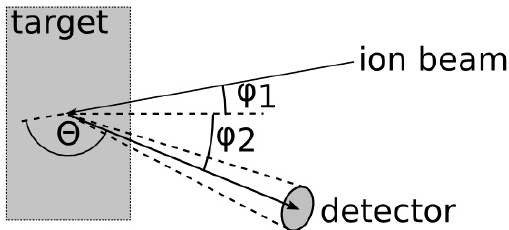
Figure 1. Schematic representation of Rutherford backscattering spectrometry (RBS). The angles of incidence and exit of the analyzing ions are ϕ 1 and ϕ 2 , respectively. Θ is the backscattering angle.